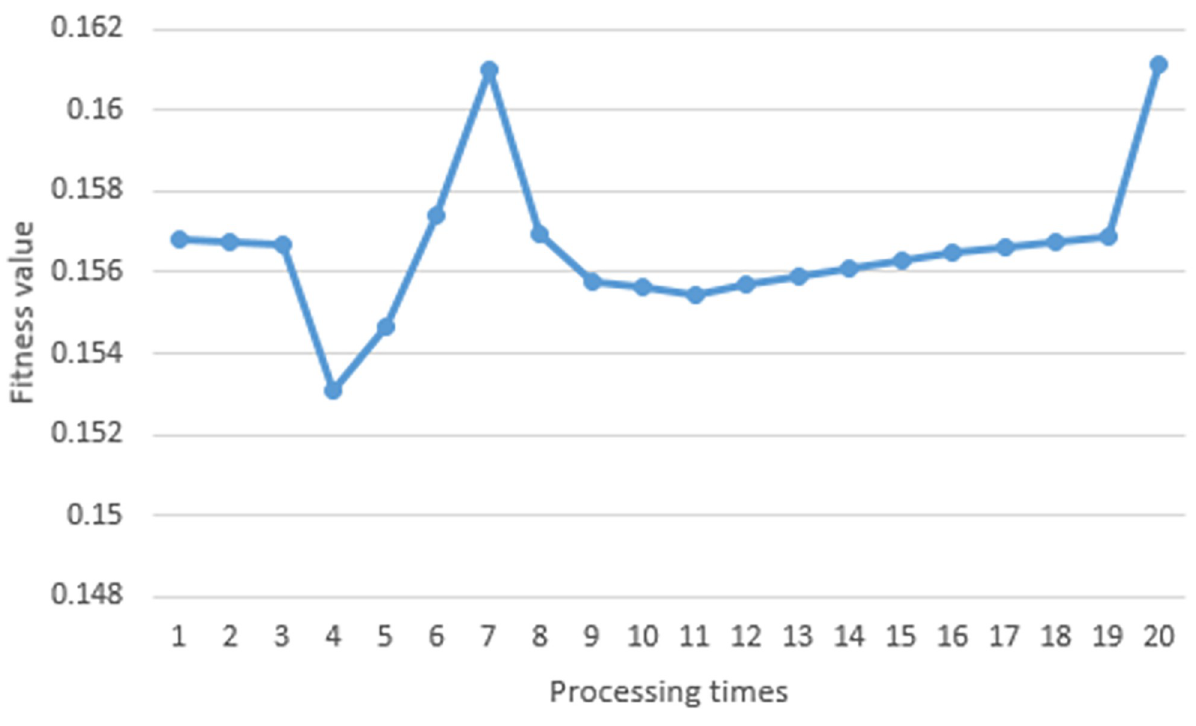
Fig 34. The fitness value obtained in a dynamic